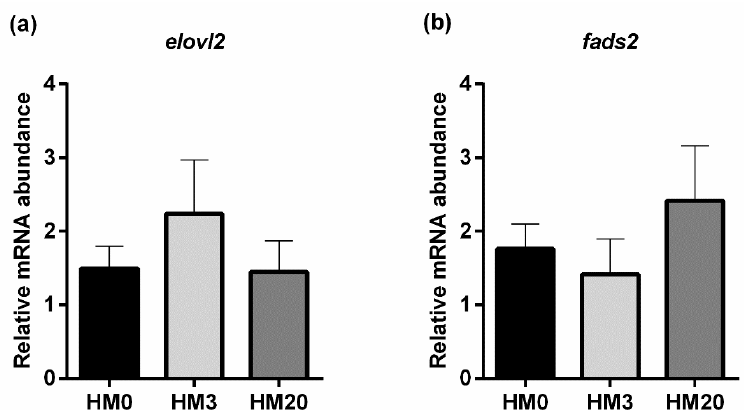
Figure 6. Relative mRNA abundance of genes involved in lipid metabolism, analyzed in pyloric caeca samples of rainbow trout fed the experimental diets. ( a ) elovl2 , ( b ) fads2 . Values are shown as mean ± SD ( n = 9).